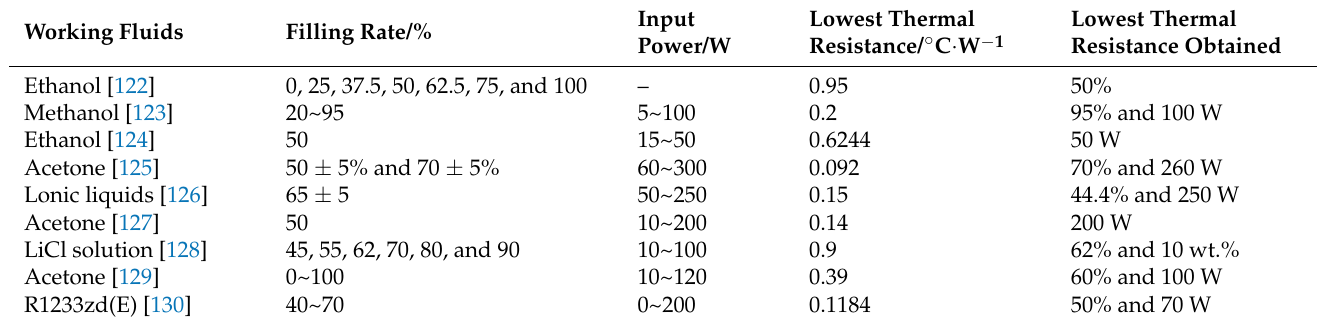
Table 3. Heat transfer performance with different organic solvent liquids as working fluids.